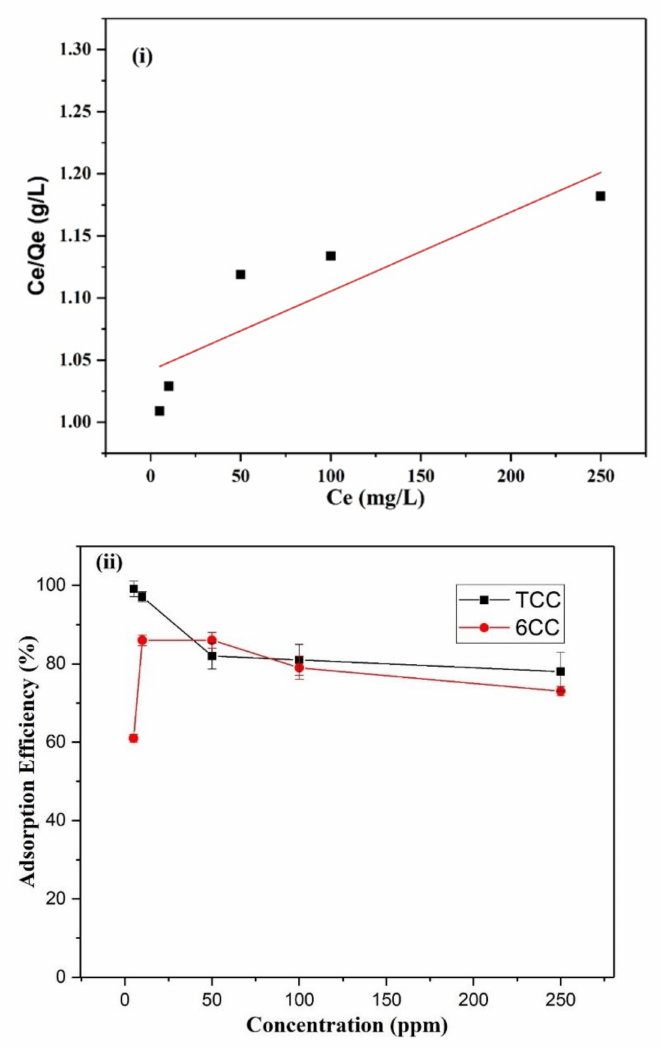
Figure 7. ( i ) Langmuir isotherm fitting for TCC; ( ii ) adsorption efficiency of 6CC and TCC. Based on the Langmuir isotherm model, the coefficient of the LSRL of Ce against Ce/Qe is 6.37316E-4 as the reciprocal of the adsorption capacity. Thus, the adsorption capacity (Qm) obtained for TCC was 1569 mg/g with R 2 0.69531, showing conformity to the Langmuir isotherm model (Figure